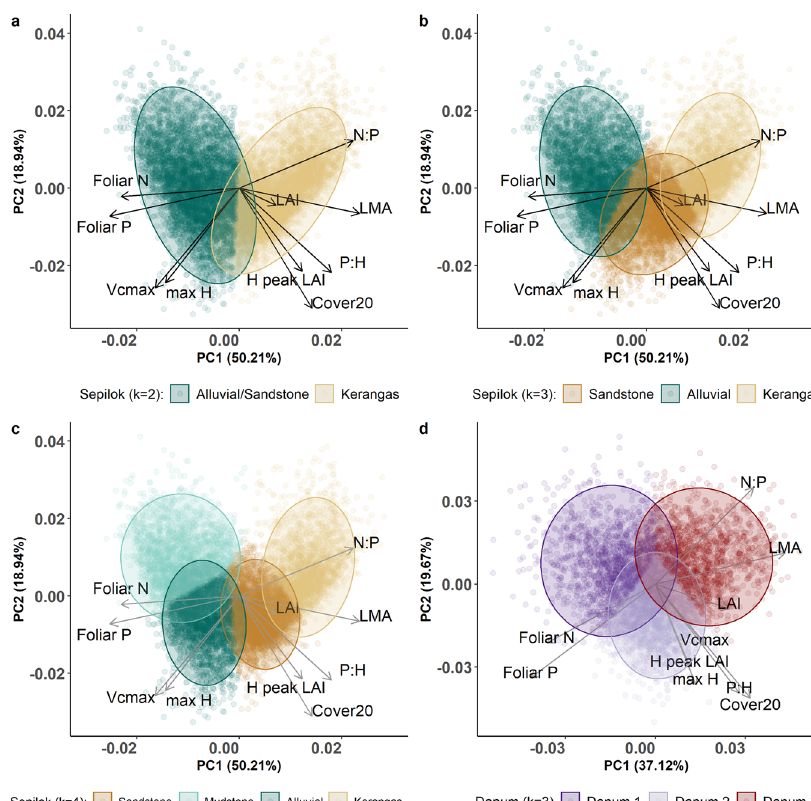
Fig. 2 Principal component analysis results. The fi rst two loadings from the principal component analysis at Sepilok ( a – c ) and Danum ( d ). a – c Illustrate the partitioning of pixels into k = 2, 3, and 4 clusters at Sepilok. d illustrates k = 3 clusters at Danum. Cover20: the percent of canopy cover at 20 m height above ground; H peak LAI: height of peak leaf area index, LAI: Leaf area index, LMA: Leaf mass per area, max H: maximum height, N: Nitrogen, N:P: Nitrogen to phosphorus ratio, P: Phosphorus, P:H: the vertical distribution of plant foliage (P) relative to the total canopy height